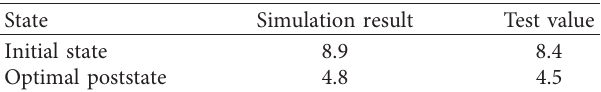
Figure 15: Diagram of power supply reinforcement: (a) printed board reinforcement, and (b) shell reinforcement. Table 2: Comparison between simulation and test results based on the high-confidence evaluation system (unit: